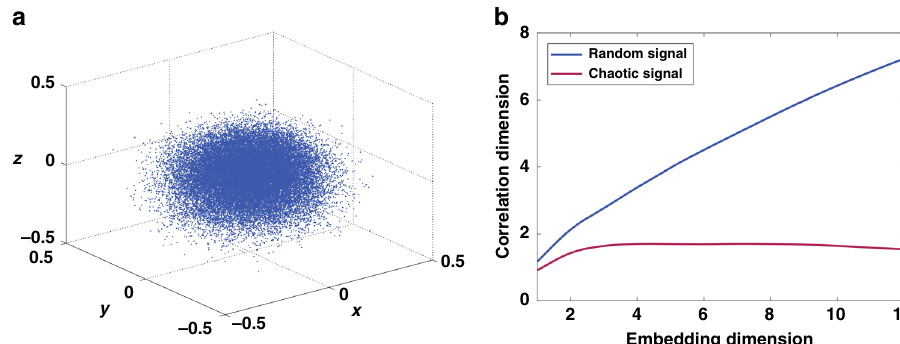
Fig. 5 The phase space and correlation dimension results. a The phase space of signal generated in the broadband random OEO, presenting a scatter plot. b The relationship between correlation dimensions and embedding dimensions of a chaotic waveform and a random waveform sampled from the broadband random OEO. Correlation dimension value tends to saturate with the increase of the embedding dimension for chaotic time series, while for random time series the correlation dimension value does not saturate.